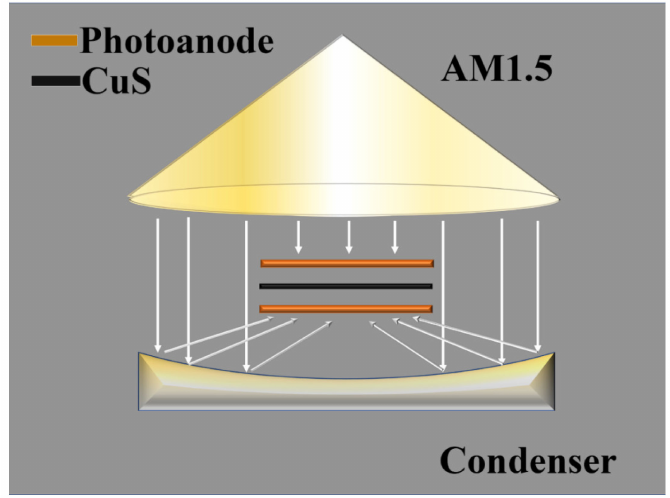
Figure 8. Schematic diagram of the cell design with dual photoanode used in the present